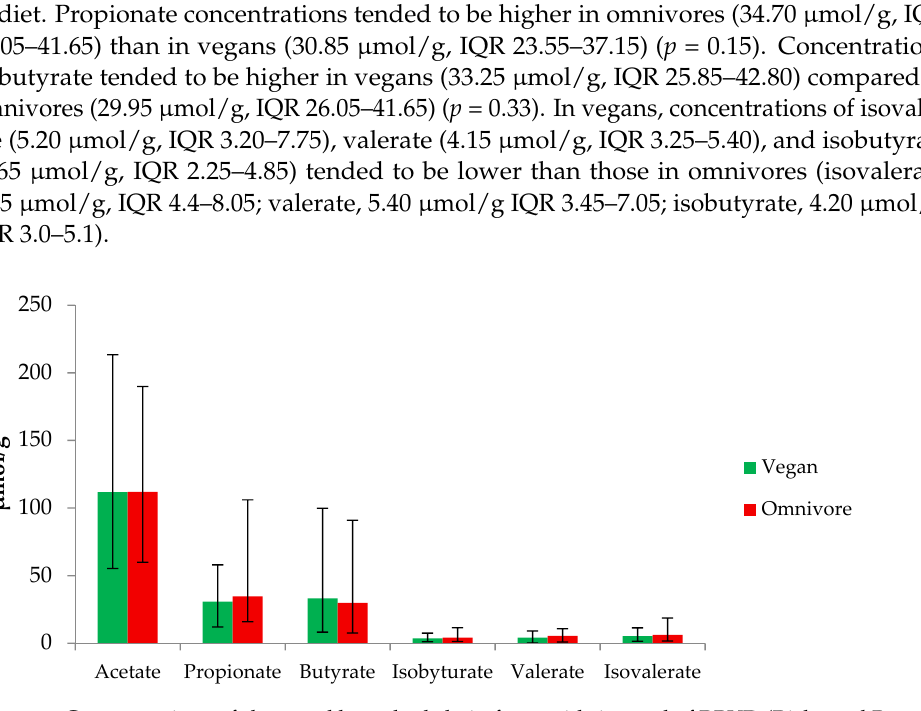
Figure 1. Concentrations of short and branched chain fatty acids in stool of RBVD (Risks and Benefits of Vegan Diet) population ( µ mol/g). Data are presented as median and interquartile range (Q1–Q3).